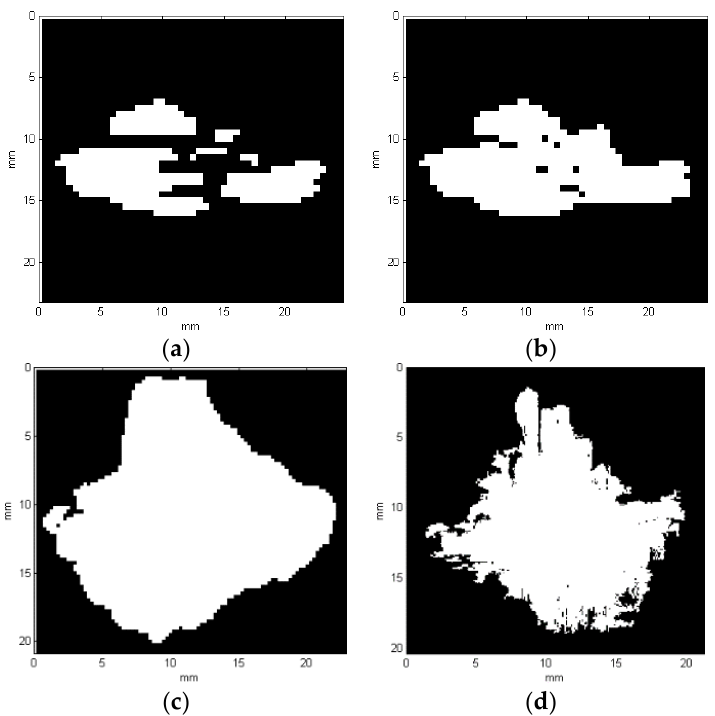
Figure 22. Planar projections of the reconstructed damage based on: ( a ) B-Scan (the first version); ( b ) B-Scan (the second version); ( c ) C-Scan; ( d ) X-ray CT scan. Table 1. Quantitative data of the reconstructed damage based on different NDT results.